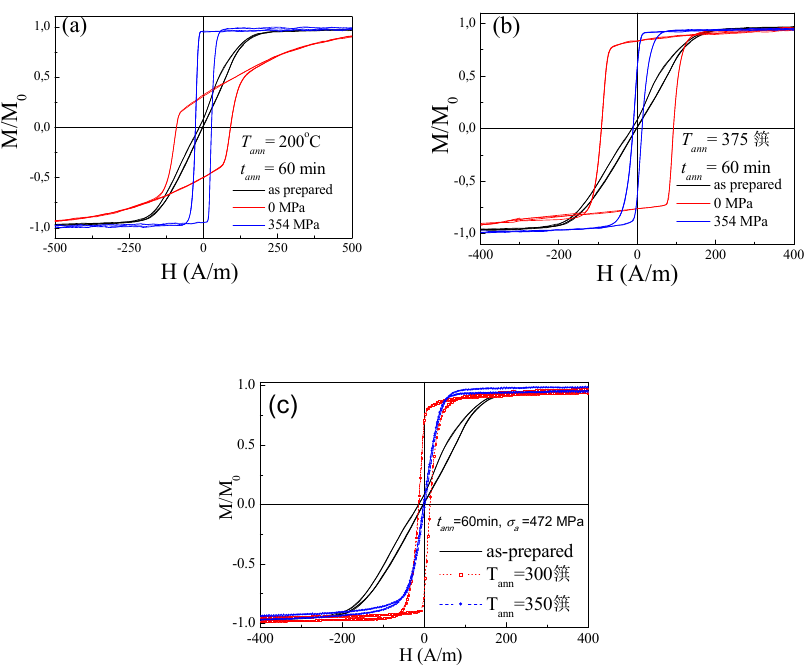
Figure 10. Hysteresis loops of Fe 3.6 Co 69.2 Ni 1 B 12.5 Si 11 Mo 1.5 C 1.2 microwires as-prepared, annealed and stress-annealed at T ann = 200 ◦ C ( a ) and T ann = 375 ◦ C ( b ) and at t ann = 60 min, σ a = 472 MPa for T ann = 300 ◦ C and 350 ◦ C ( c ).